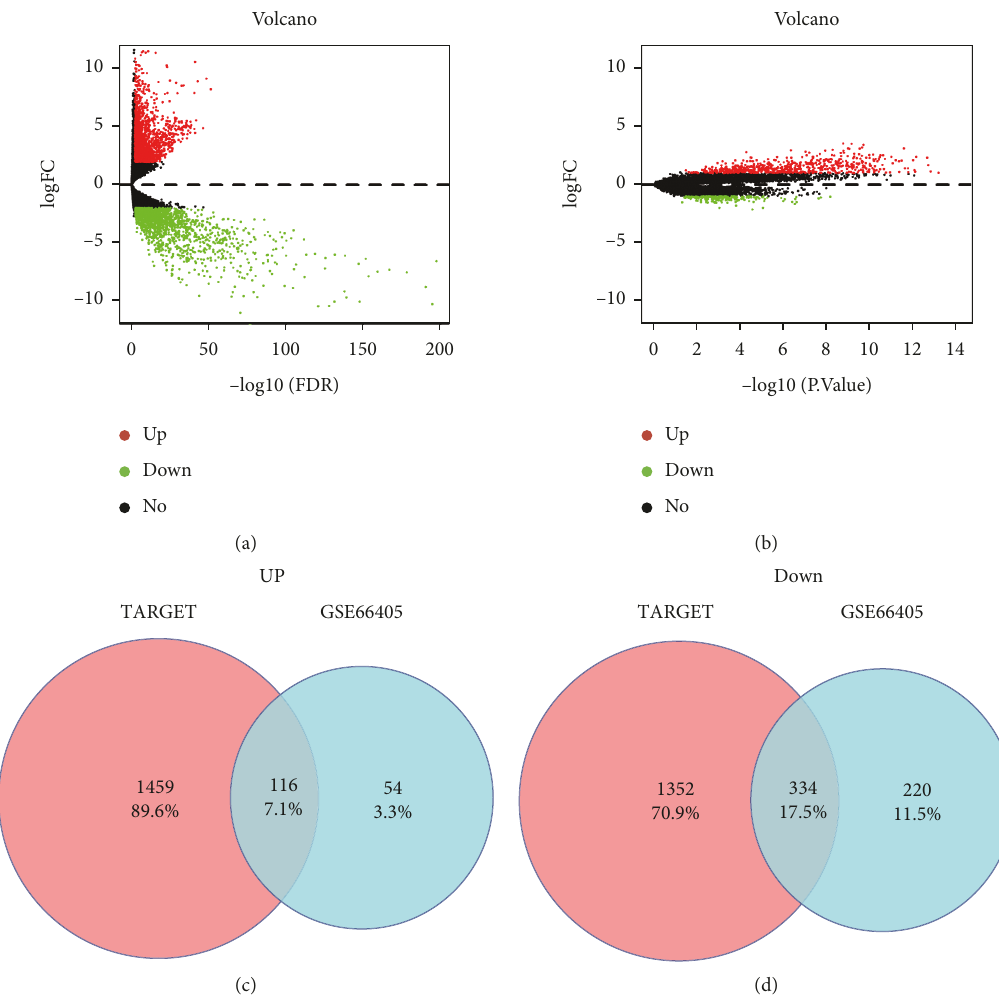
Figure 2: Identification of WT-specific mRNAs. Differentially expressed mRNA in TARGET (a) and GSE66405 (b) with the afore- mentioned cutoff thresholds is depicted in the volcano map. The red/green points represent the upregulation/downregulation of mRNAs, and the black points represent RNAs with no significant difference. The 116 upregulated (c) and 334 downregulated (d) WT-specific mRNAs convergence in both databases is presented in Venn